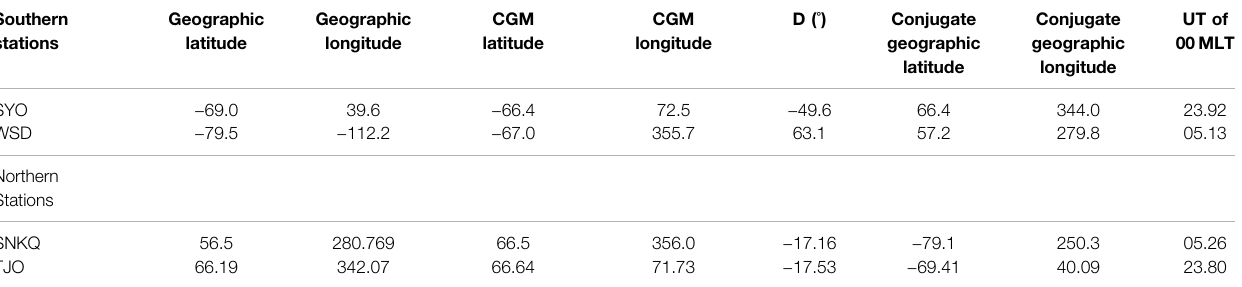
TABLE 1 | Station location information for the southern and northern ground magnetometer data. From left to right the columns are station name, geographic latitude and longitude, corrected geomagnetic latitude and longitude, magnetic declination, and conjugate geographic latitude and longitude. Southern Geographic stations